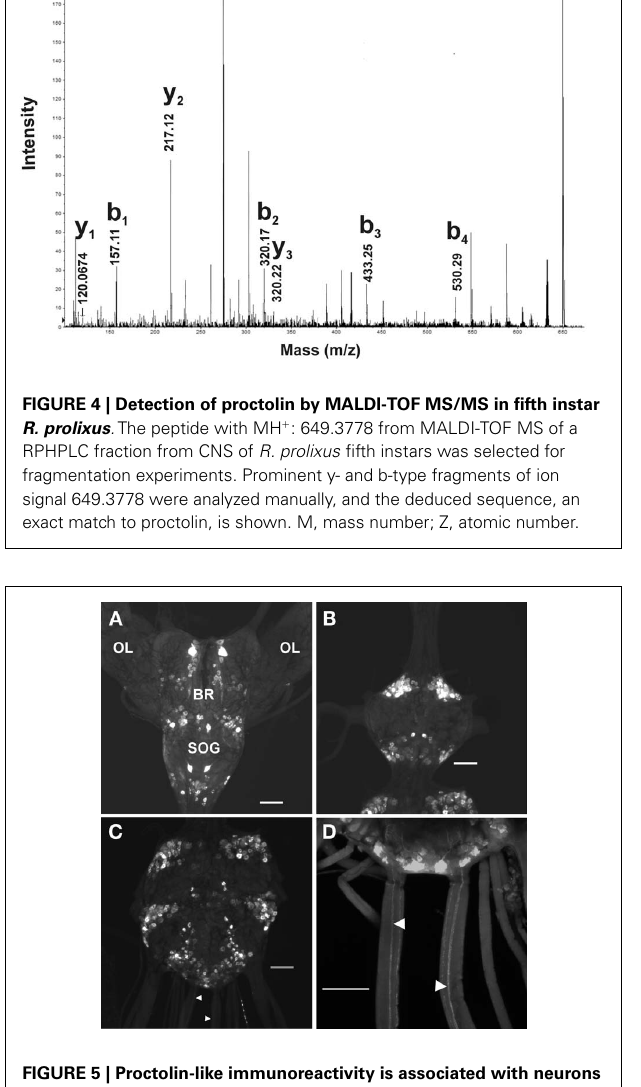
FIGURE 5 | Proctolin-like immunoreactivity is associated with neurons in the CNS of fifth instar R. prolixus. Whole mount preparations show clusters of bilaterally paired proctolin-like immunoreactive neurons in the (A) brain (BR) and subesophageal ganglion (SOG), (B) prothoracic ganglion, and (C,D) mesothoracic ganglionic mass. Axons (arrowheads) projecting through the main trunk nerves of the mesothoracic ganglionic mass (C,D) . OL, optic lobe. All scale bars = 100 μ m, n = 10.